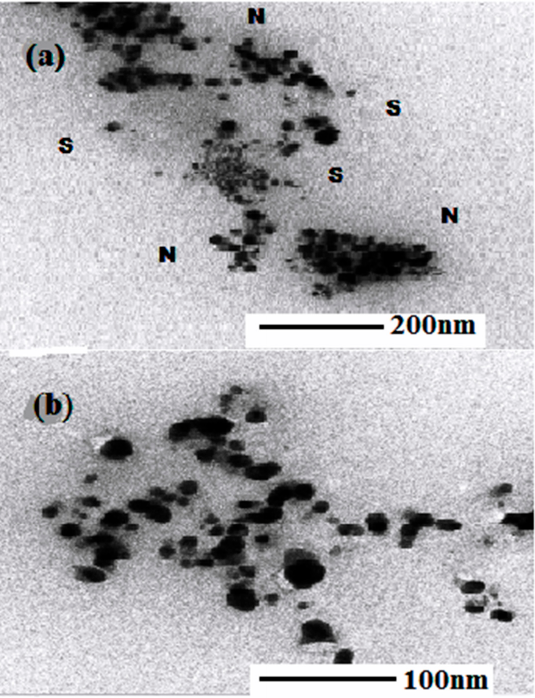
Figure 3. TEM images (100 nm scale bar) of AgNPs synthesized by S. officinarum extract: ( a ) AgNPs surrounded by stabilizing agents and ( b ) AgNPs.